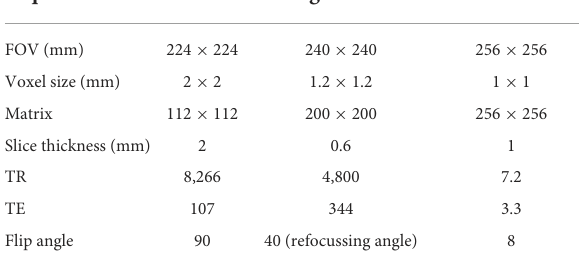
TABLE 1 MR imaging parameters.